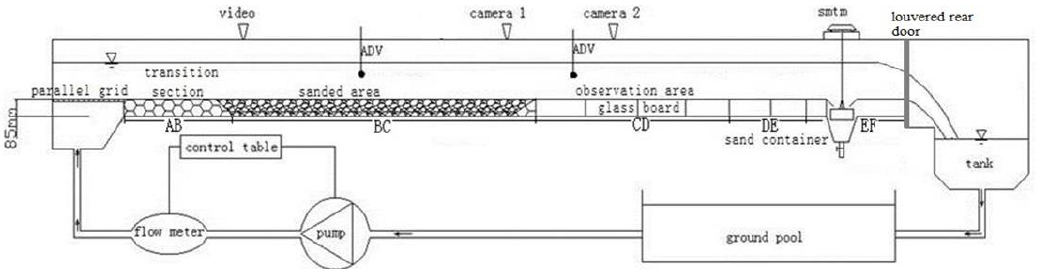
Figure 1. Layout of the flume system. The figure shows a flume system of self-circulation, where experiments were conducted. The system includes the flume, pool, tank, and measurement instruments. The parallel grid composed with several rows of parallel pipes was set in the start of the flume so as to ensure the flow steady. The main instruments are ADV, high-speed camera, and SMTM. This figure helps provide and understanding of the arrangement of experimental instruments.